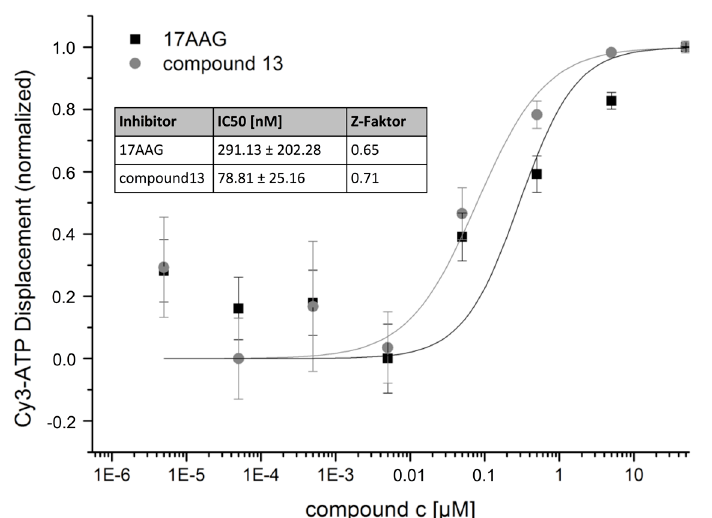
Figure 2a. Typical displacement assay of Cy3-ATP on AtHSP83 by geldanamycin derivative. Purified AtHSP83 was printed on the microarray surface and Cy3-ATP was competed by a geldanamycin derivative, synthesis and properties given in Schax et al., [13]. The IC was obtained from dose-response curve fittings.